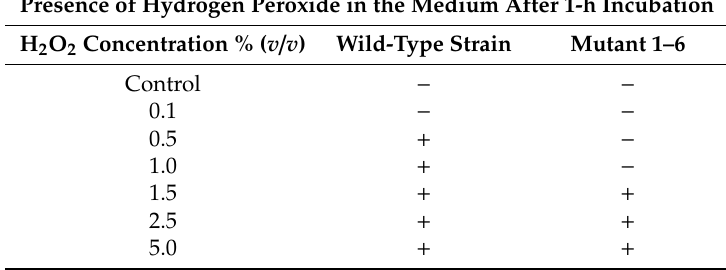
Table 2. Comparison of resistance of the parental strain and mutant 1–6 of the fungus C. pannorum A-1 to hydrogen peroxide as measured by their H 2 O 2 decomposition